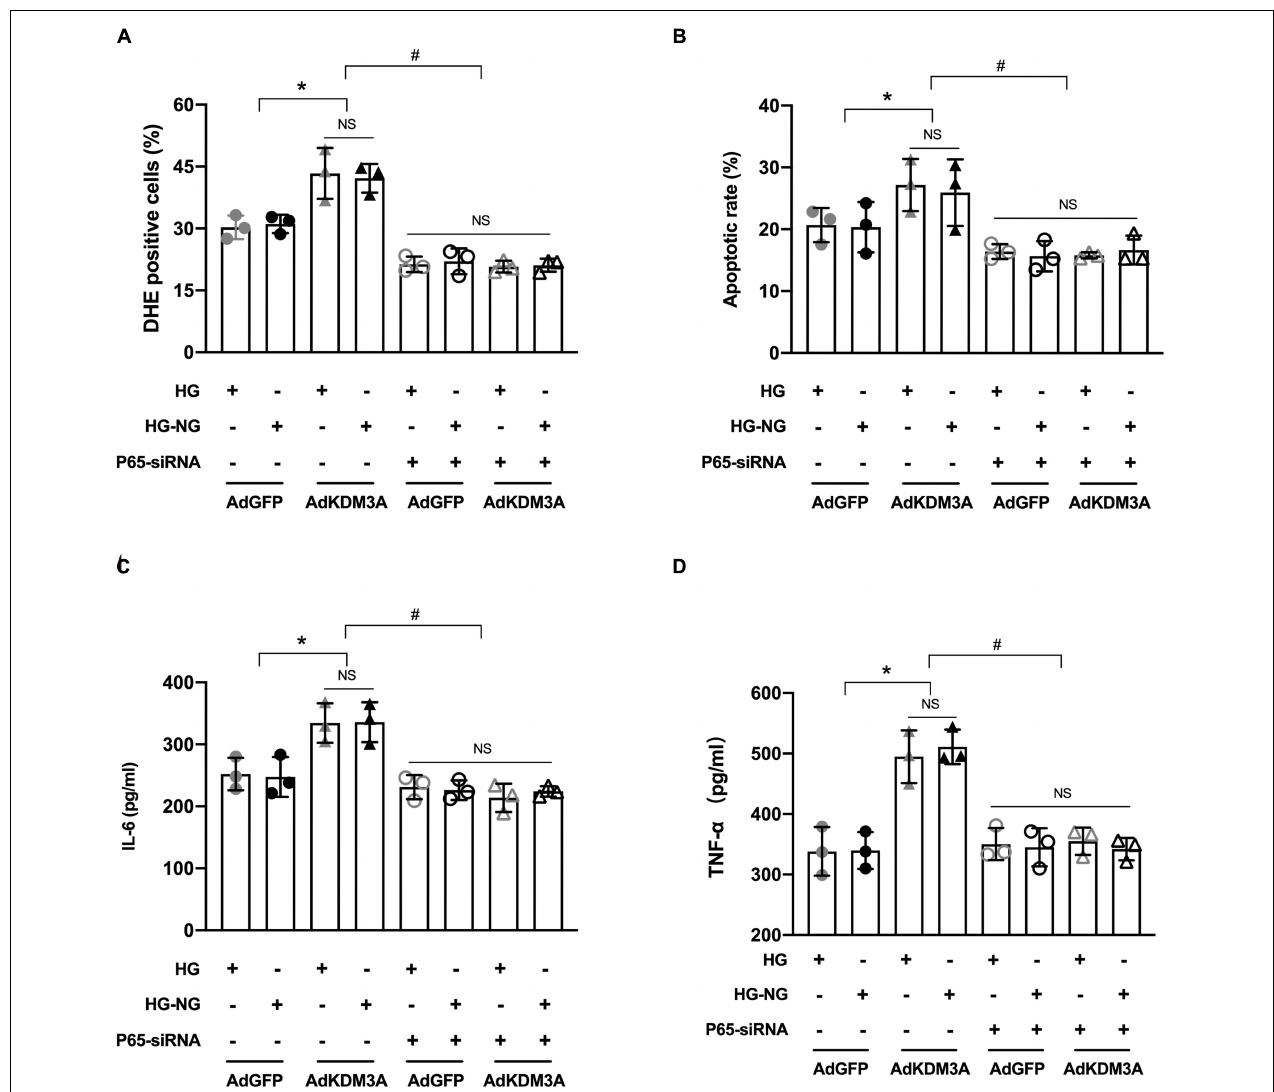
FIGURE 7 | KDM3A regulates high glucose-induced cardiomyocytes dysfunction in an NF- κ B/P65 dependent manner. To further investigate whether KDM3A affects hyperglycemia-induced impairment in diabetic myocardium through the P65/NF- κ B dependent pathway, primary cardiomyocytes infected by AdKDM3A were also transfected with P65 siRNA plasmid, which was inhibiting P65 expression. Subsequently, these cells were given HG or HG–NG treatment, respectively. The ROS production (A) , apoptosis (B) , and inflammatory factors (C,D) were evaluated. * p < 0.05, as compared to the AdGFP + HG or AdGFP + HG–NG; n = 3, # p < 0.05, as compared to the AdKDM3A + HG or AdKDM3A + HG–NG. Here, NS means no significant